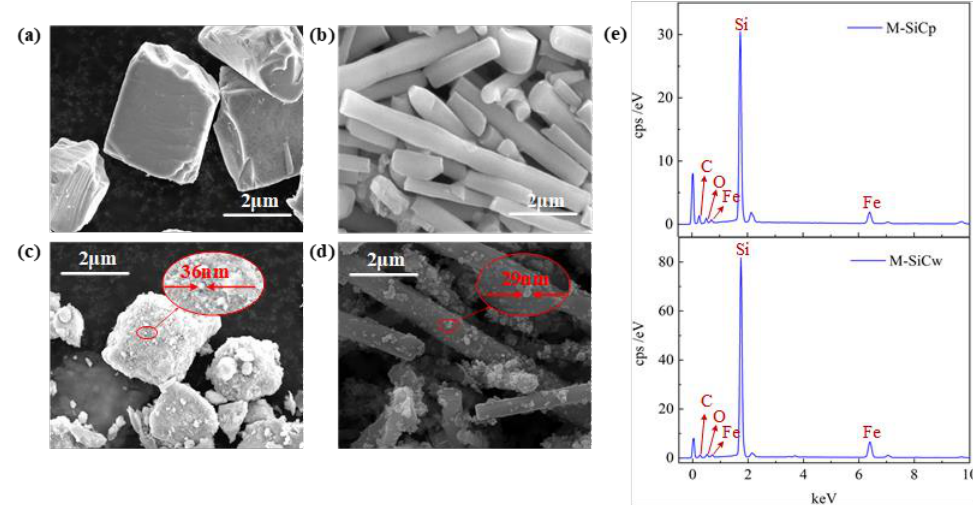
Figure 5. The SEM images and EDX spectrum of SiC before (R-SiC) and after (M-SiC) chemical deposition. (a) SEM image of R-SiCp; (b) SEM image of R-SiCw; (c) SEM image of M-SiCp; (d) SEM image of M-SiCw; (e) EDX spectra of M-SiC.